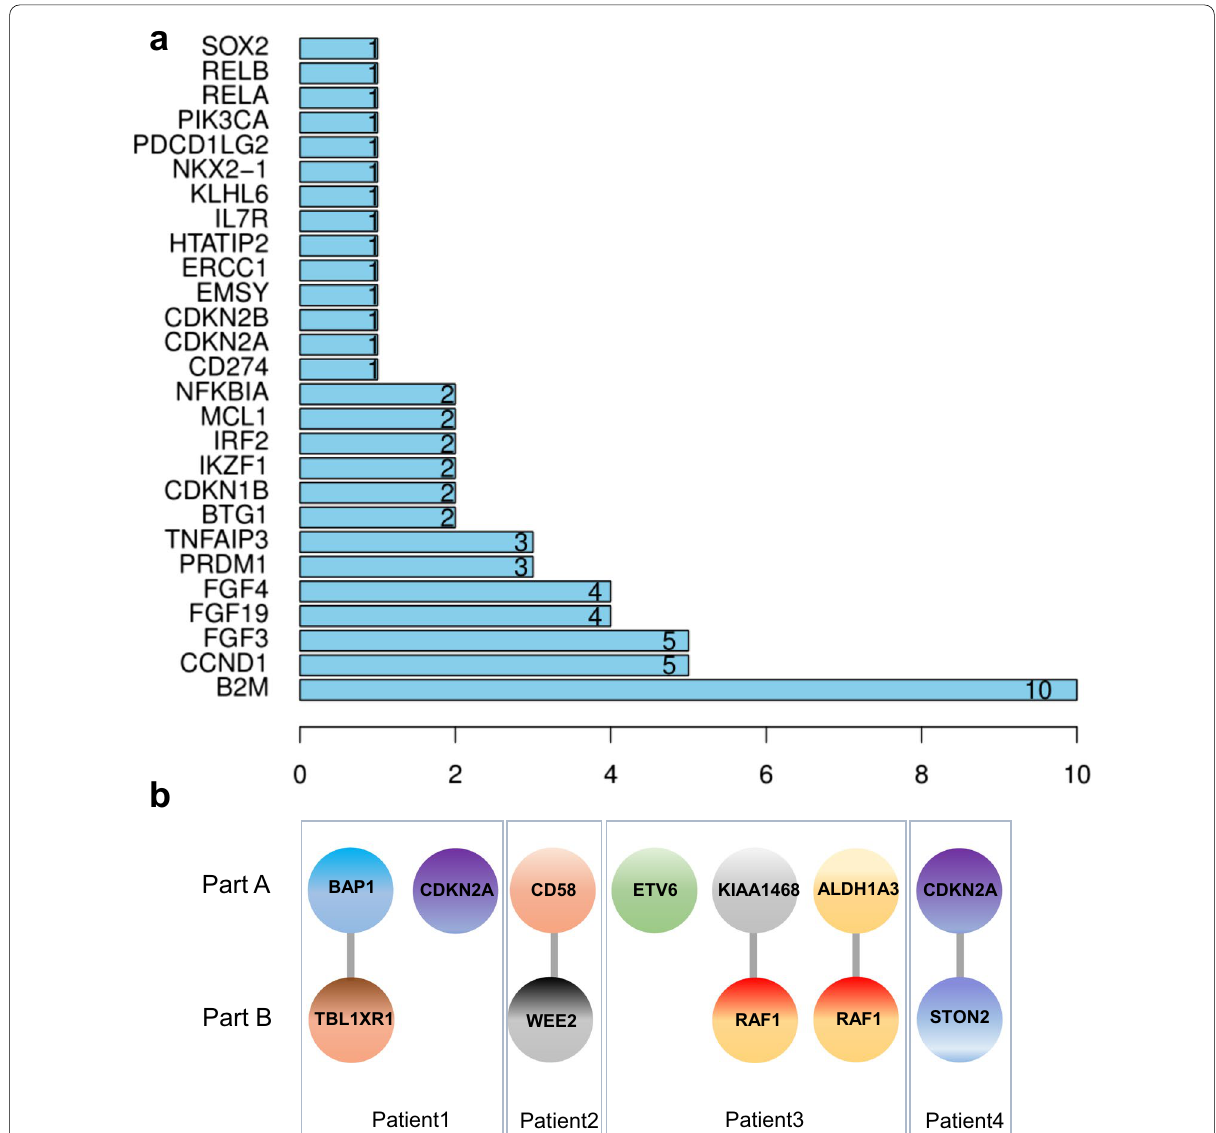
Fig. 2 Copy number alterations and fusion/rearrangement. a Frequency of copy number variation per gene. b All of the fusion and rearrangement